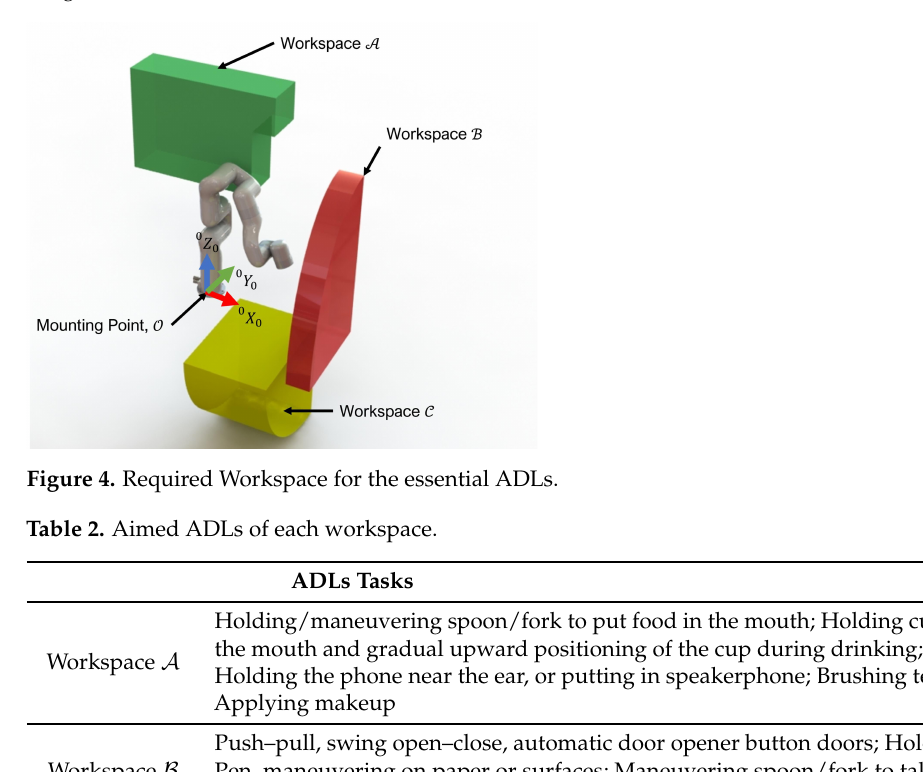
Figure 3. Activities of daily living achieved with different control systems. ( a ) Picking/placing an object from a table. ( b ) Picking an object from upper shelf. ( c ) Eating with a fork. ( d ) Picking up an object from the ground.